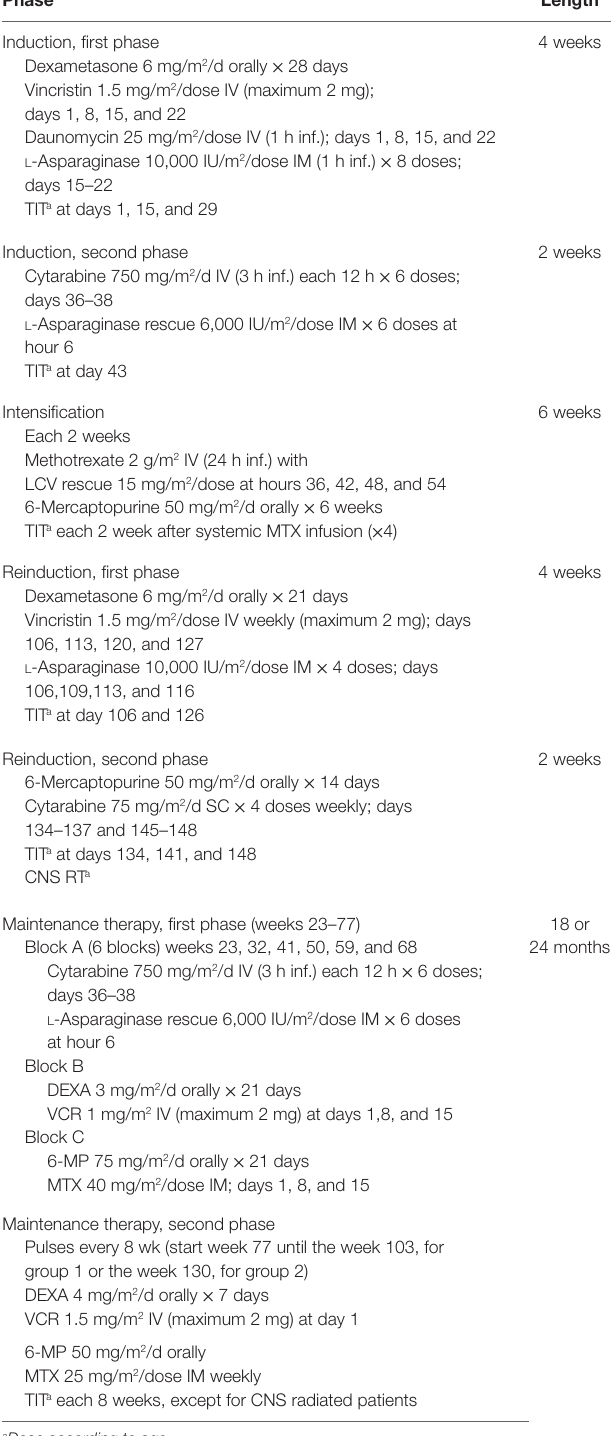
TaBle 2 | Therapy for high risk all patients on gBTli all-93 protocol. Phase